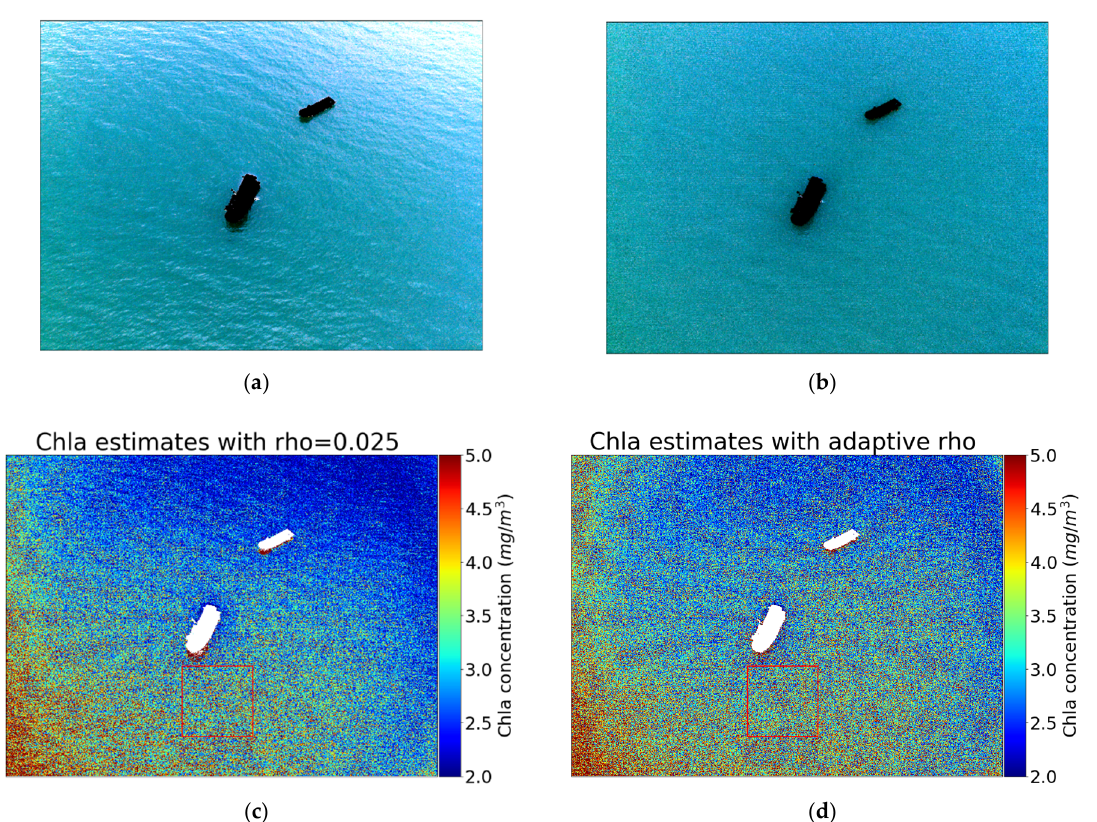
Figure 5. Images of remote sensing reflectance ( a , b ) and the Chla estimates from the respective R rs images ( c , d ) for Scene-A. A fixed Fresnel reflectance factor was applied to panel ( a ) and the adaptive approach was used for panel ( b ).